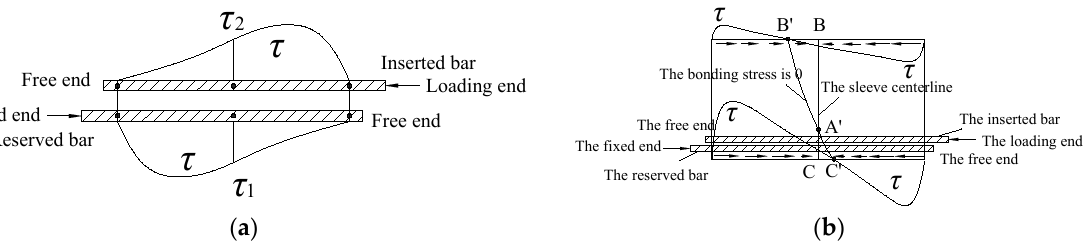
Figure 23. Bonding stress at the initial stage of loading (compression load). ( a ) Bonding stress distribution of steel bar, ( b ) Bonding stress of sleeve.